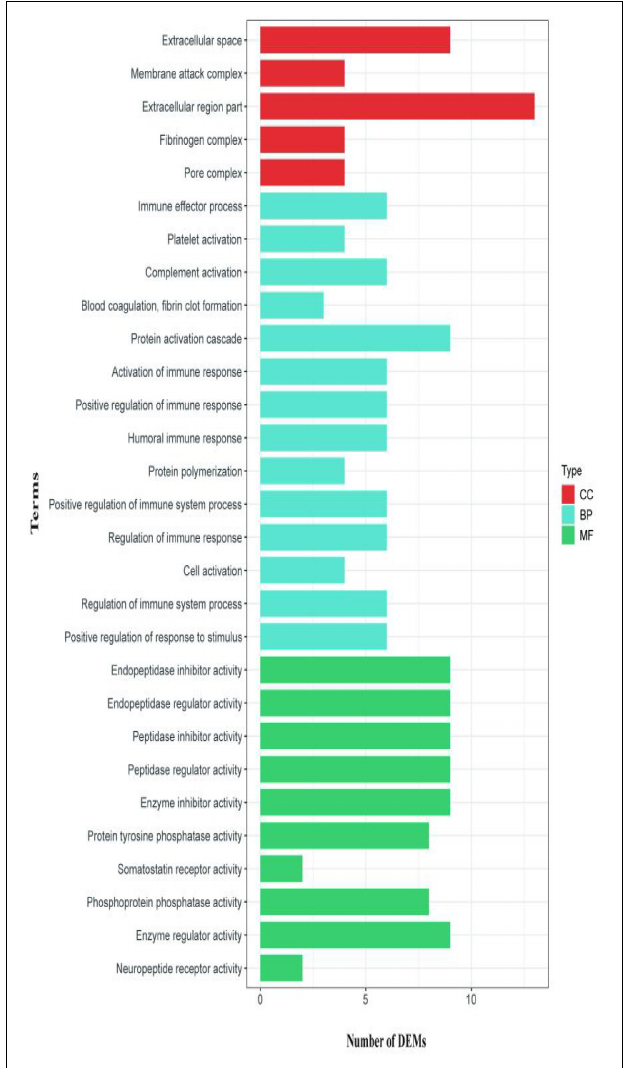
FIGURE 7 | Gene Ontology (GO) enrichment analysis for differentially expressed mRNAs (DEMs) of transcriptome at 5 dpi.